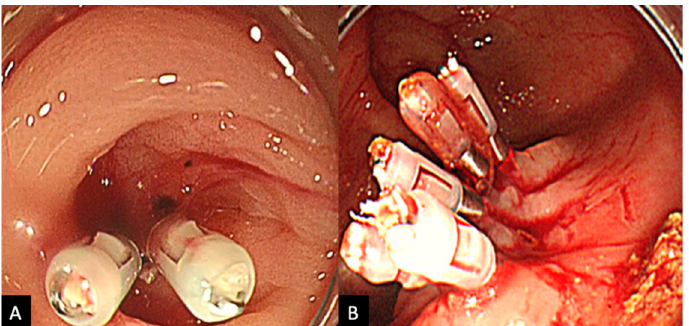
Figure 3. ( A ) Direct clipping: clips are administered directly upon the bleeding diverticulum. ( B ) Indirect clipping: bleeding diverticulum is sealed off indirectly using a zipper-like method.